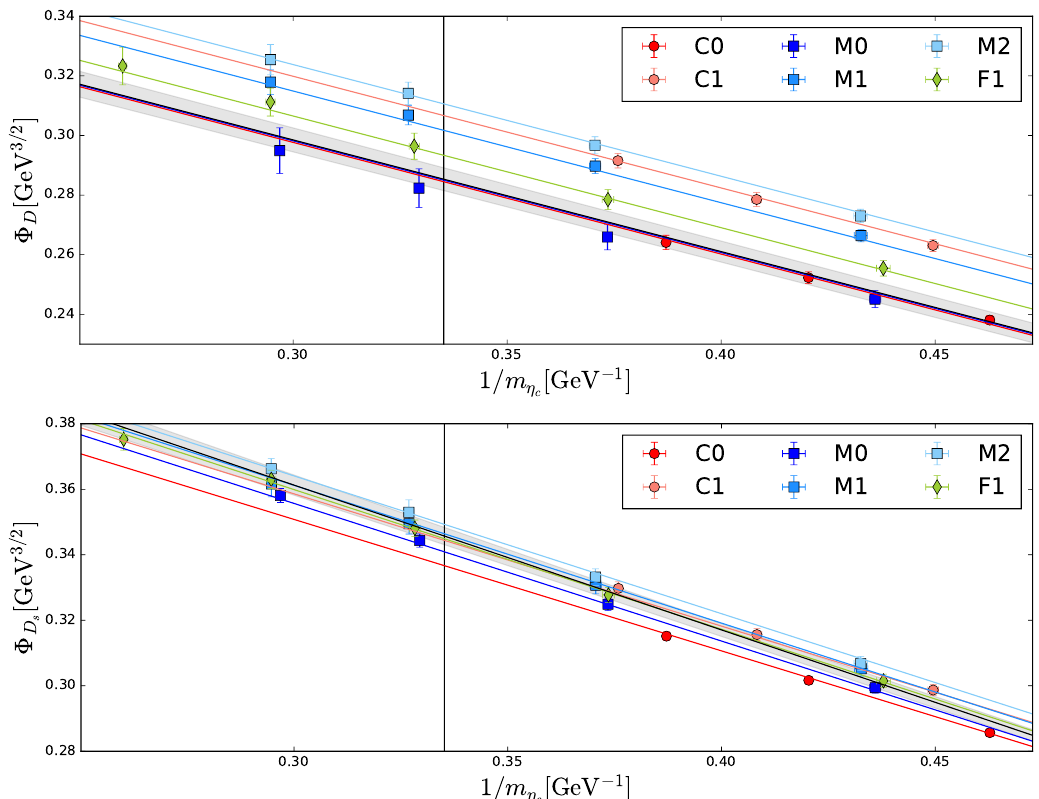
Figure 11 . Examples for the global (cid:12)t according to (3.6) for the case of the observables (cid:8) D (top) and (cid:8) D (bottom). In both cases the charm-quark mass is (cid:12)xed by the (cid:17) c meson and a pion mass s cut of m (cid:25) < 400MeV is employed. Again, the grey band shows the (cid:12)t result at physical pion masses and vanishing lattice spacing. The coloured bands correspond to the (cid:12)t projected to the given pion mass and lattice spacing for the corresponding ensembles. More details about these (cid:12)ts can be found in the